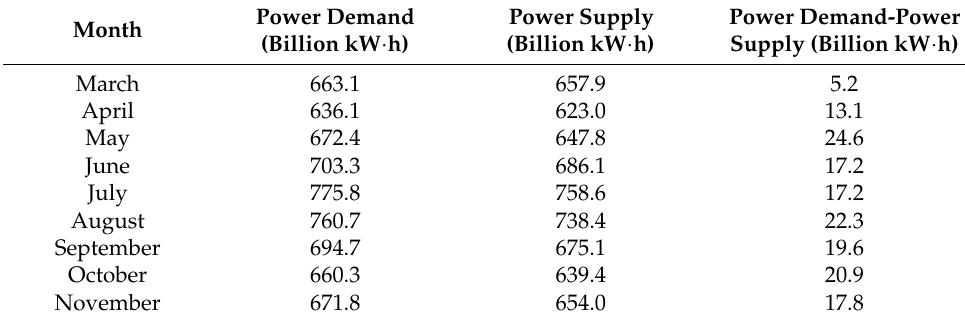
Table 1. Power demand-supply gaps from March to November 2021.